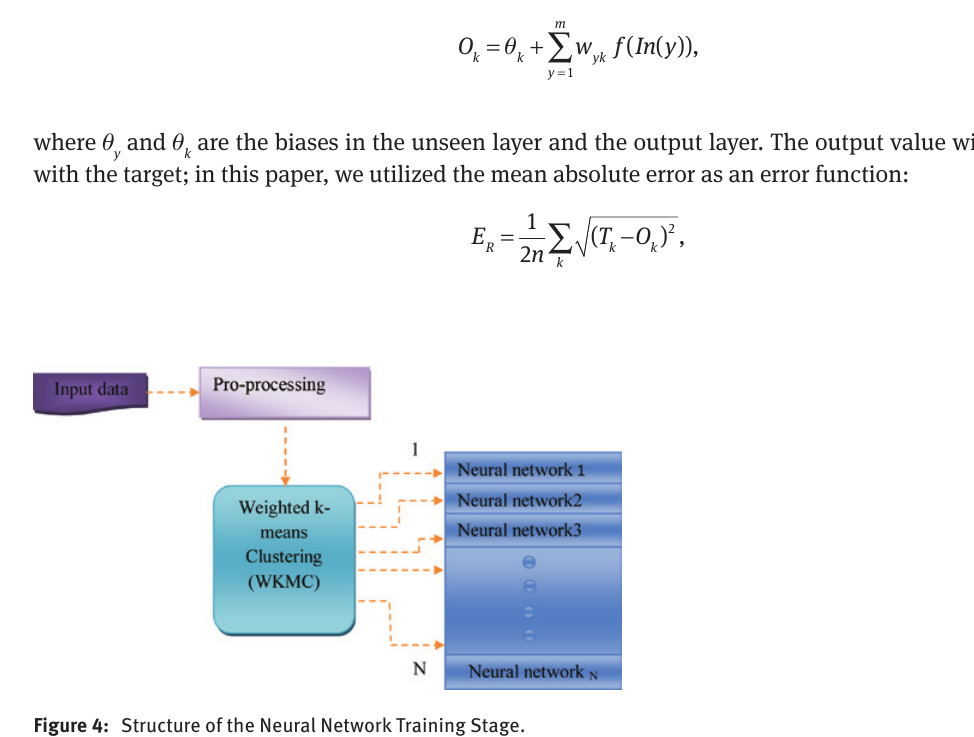
Figure 4: Structure of the Neural Network Training